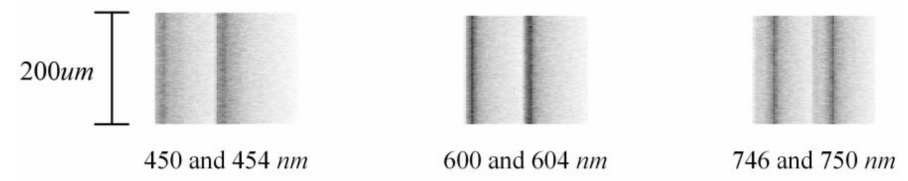
Figure 3. Diagram of the beam pattern on the